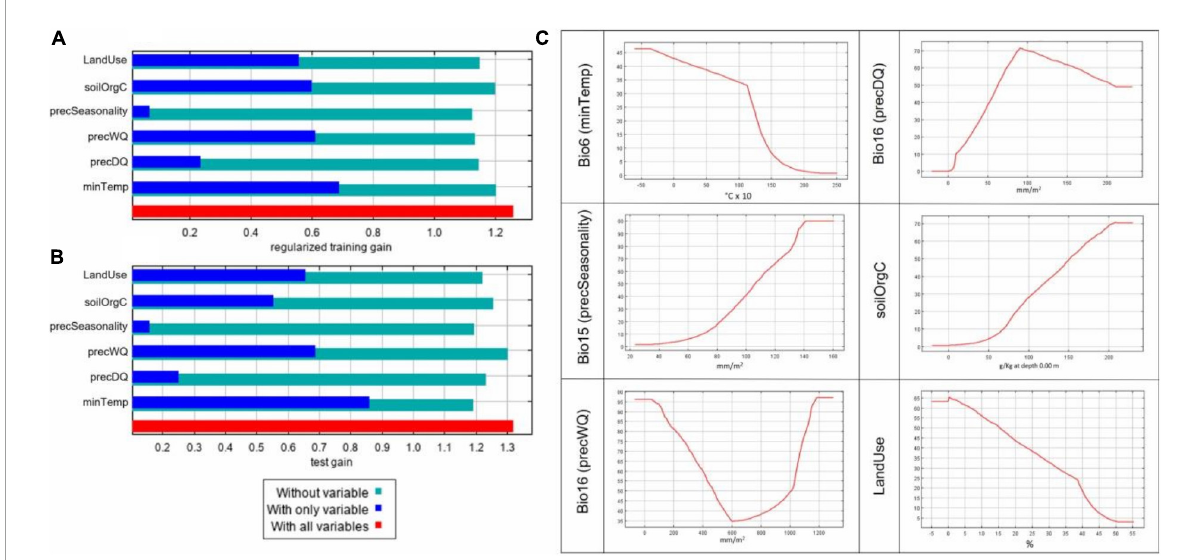
FIGURE4 Predictive powers of individual environmental variables in ENM. Results from the combined model based on all 25 populations using 6 selected environmental predictors showing (A) Jacknife of training gains for models with or without a variable, (B) Jacknife of test gain for models with or without a variable, and (C) marginal response curves for individual variables. The X -axis in the response plots shows the environmental values and Y -axis shows the logistic output for probability of